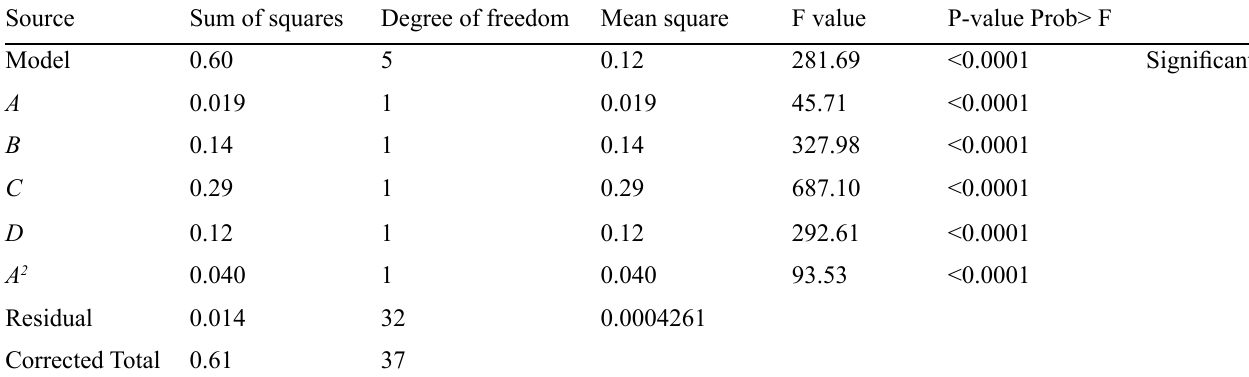
Table 4. ANOVA with CI = 95% for model and